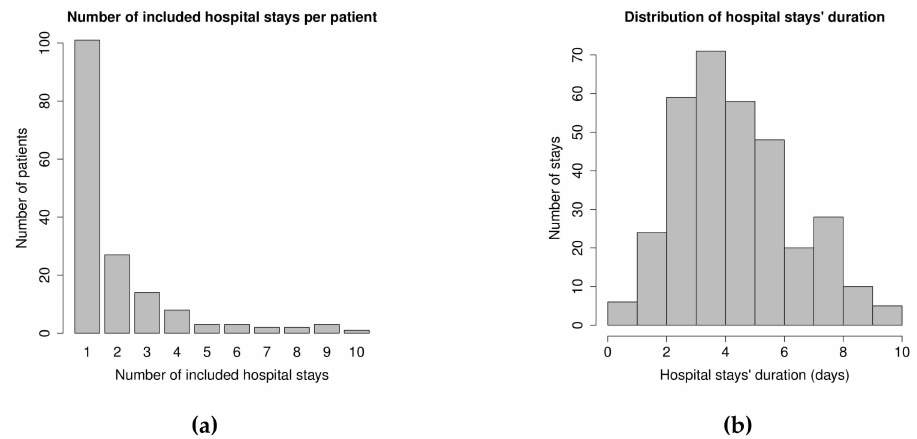
Figure A1. Stay-related statistics: ( a ) number of included hospital stays per patient; ( b ) distribution of hospital stays’ duration.